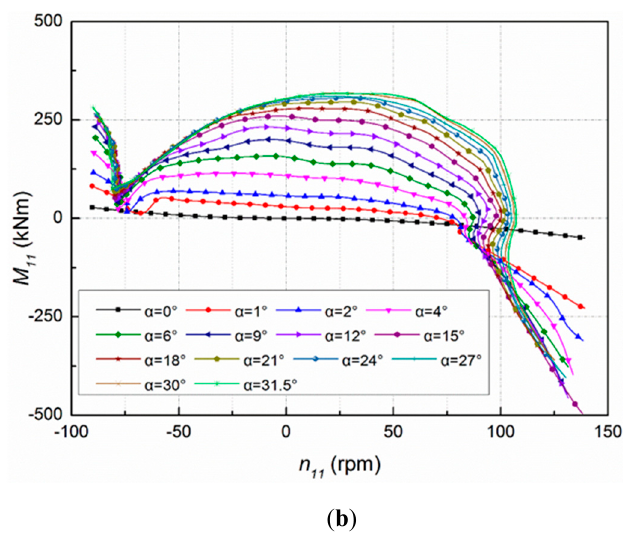
Figure 2. The characteristic curve of the pump turbine: ( a ) Unit discharge and unit speed four-quadrant characteristic curve; ( b ) Unit moment and unit speed four-quadrant characteristic curve.